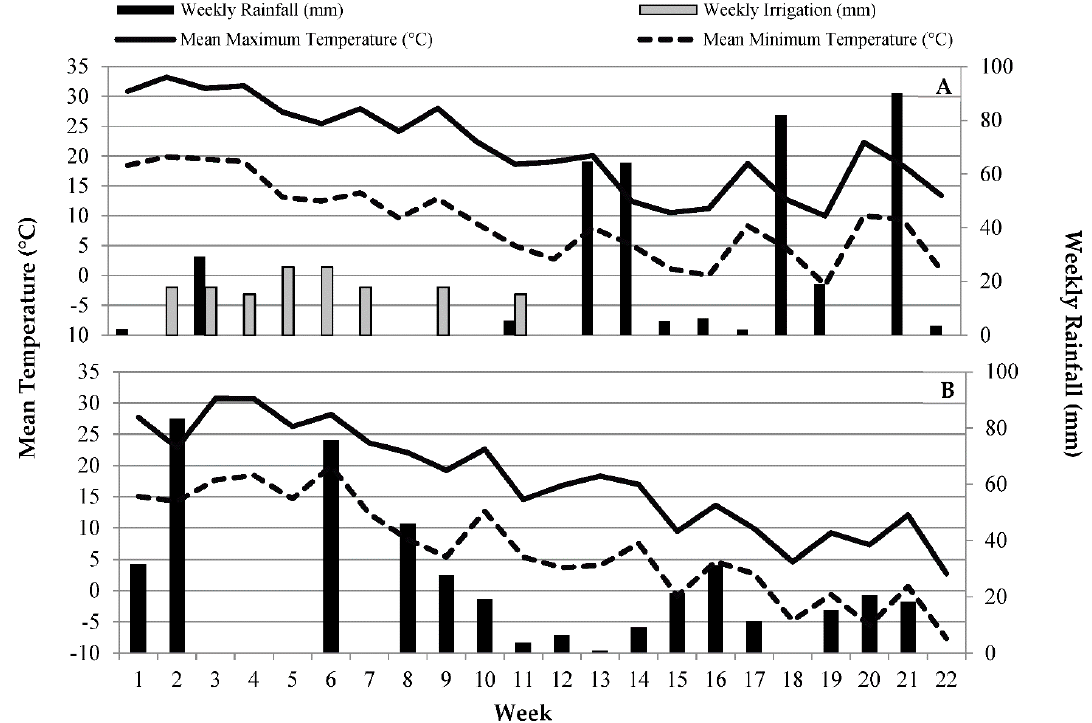
Figure 2. Mean maximum and minimum temperature for the 2016–2017 ( A ) and 2017–2018 ( B ) growing seasons of the hybrid brassica trial. Week 1 corresponds to the week of the 1 September planting date and week 22 corresponds to the end of January of each year.